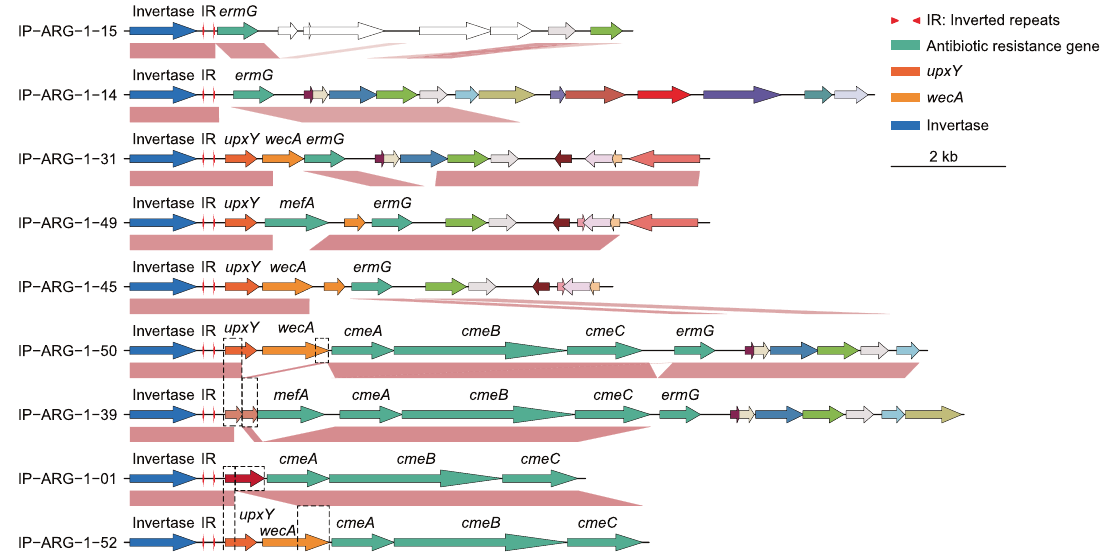
Fig. 3 Comparisons of highly variable regions carrying IP-ARG-1 demonstrate the degeneration of the upxY gene. Different degeneration statuses of the upxY gene are: completely degenerated (IP-ARG-1 – 14 and IP-ARG-1 – 15), partially degenerated (IP-ARG-1 – 39), fusion gene (IP- ARG-1 – 01), and intact gene (the remainder). Orthologous genes are plotted with the same color and are linked by pink connections. Site- speci fi c recombinase, antibiotic resistance, and glycan-synthesis genes are colored blue, light green, and orange, respectively. The genes that do not have orthologs are